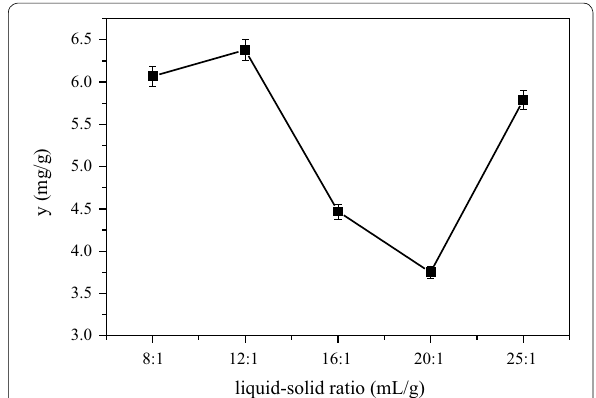
Fig. 6 Effects of ratio of liquid–solid on yield of phytosterols from CS